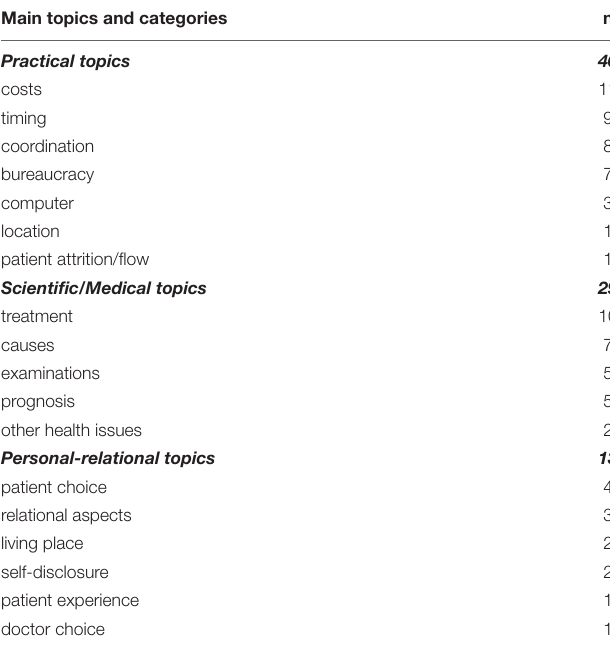
TABLE 2 | Type and frequency of doctors’ “non lo so” ( n =